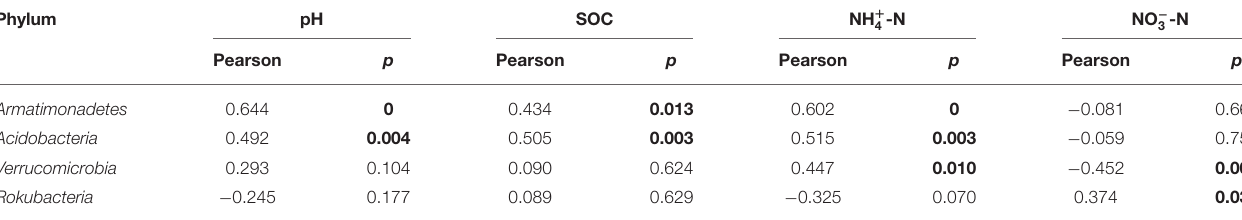
TABLE 3 | Pearson’s correlation between soil properties and phylum abundance in the bacterial community. Phylum pH SOC NH + 4 -N Pearson p Pearson p Pearson